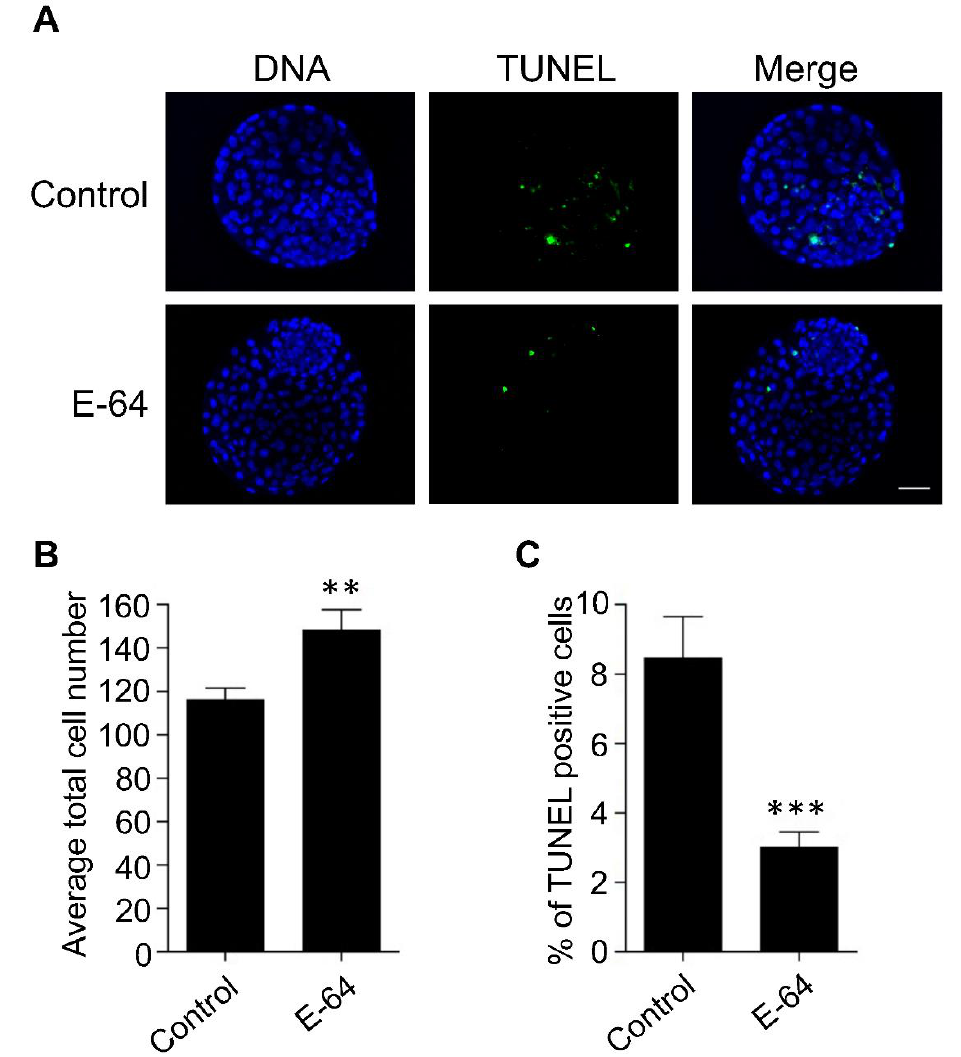
Figure 3. Effect of E-64 supplementation during in vitro maturation on the quality of preimplantation embryos. Bovine COCs were recovered from live animals using ultrasound-guided transvaginal ovum pick-up technique. Recovered COCs were in vitro matured in the presence or absence of 1 µ M of E-64 followed by IVF and culture. ( A ) Day 7 blastocysts were examined using TUNEL staining (green) to assess the apoptotic status and DAPI (blue) to assess the total cell number. Shown are representative images. ( B ) Quantification of the average total cell number. ( C ) Quantification of the percentage of TUNEL positive cells. Total number of oocytes used is 46. The experiments were carried out three times. The data are expressed as mean ± SEM; Student’s t -test was used to analyze the data. Values with asterisks vary significantly, ** p < 0.01, *** p < 0.001.